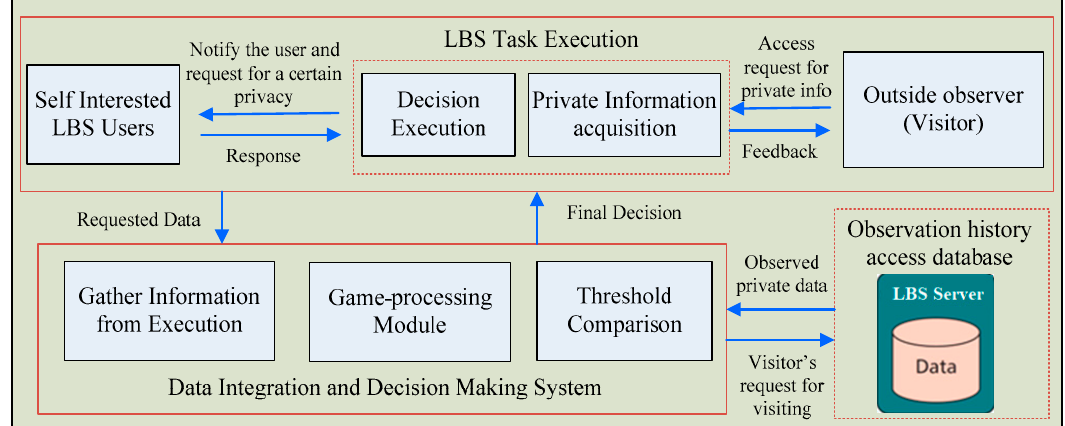
Figure 3. A Framework Design of the game-theory based privacy protection model.